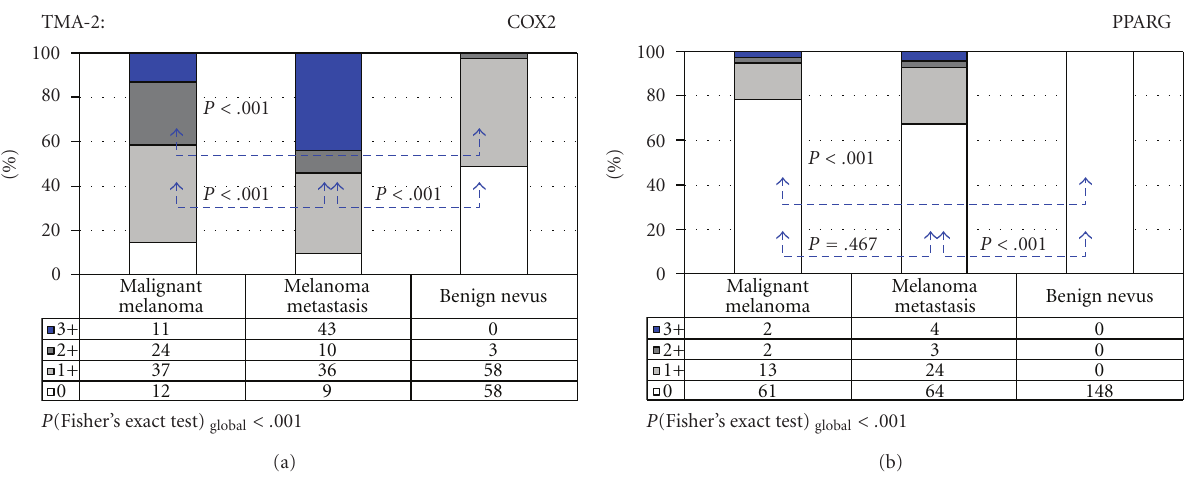
Figure 2: Cumulative bar charts of COX2 (a) and PPARG (b) immunoreactivity in melanocytic skin tumors using